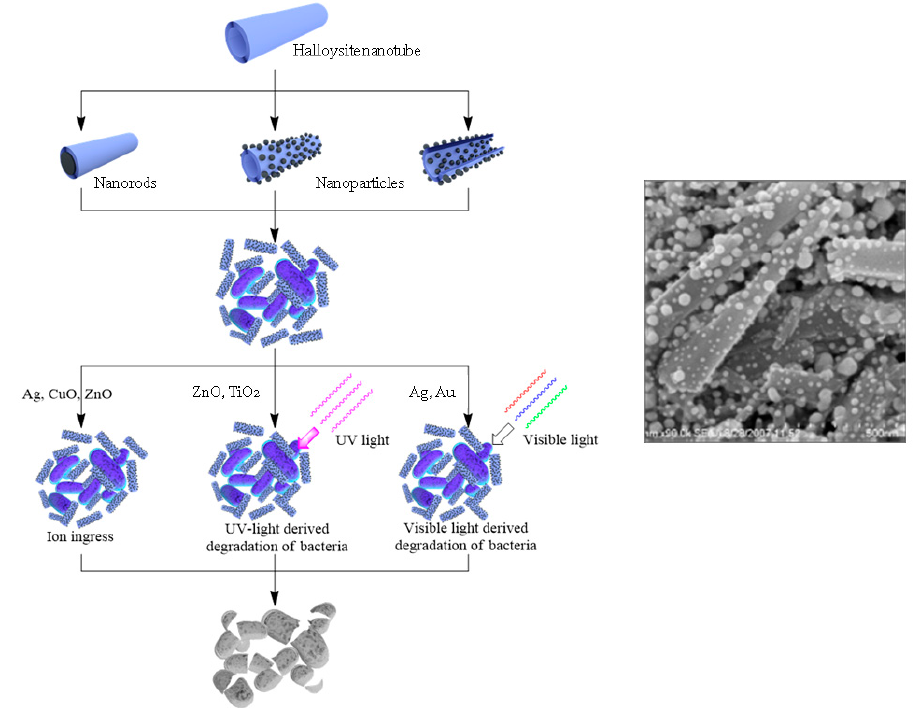
Figure 7. Scheme of antibacterial metal structures deposition onto / into the nanotubes, with their antibacterial applications and image of silver particles coated onto halloysite.